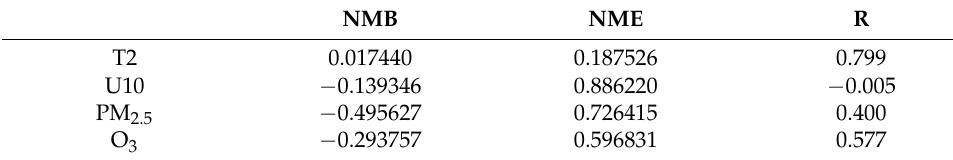
Table 2. Model simulation in Chengdu, July 2017.